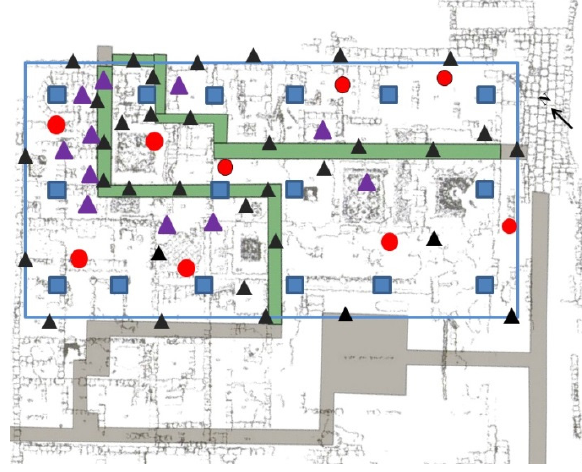
Figure 7. Roman Domus plan with scan positions of the two campaigns: Tocon GLS-2000 scans (in red and violet) and Faro Focus scans (in black).